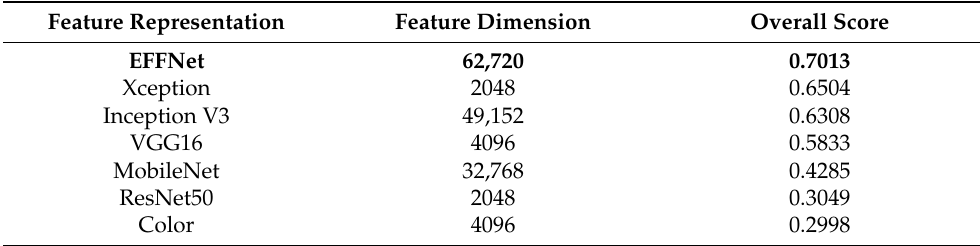
Table 25. A comparison of feature dimension and overall accuracy